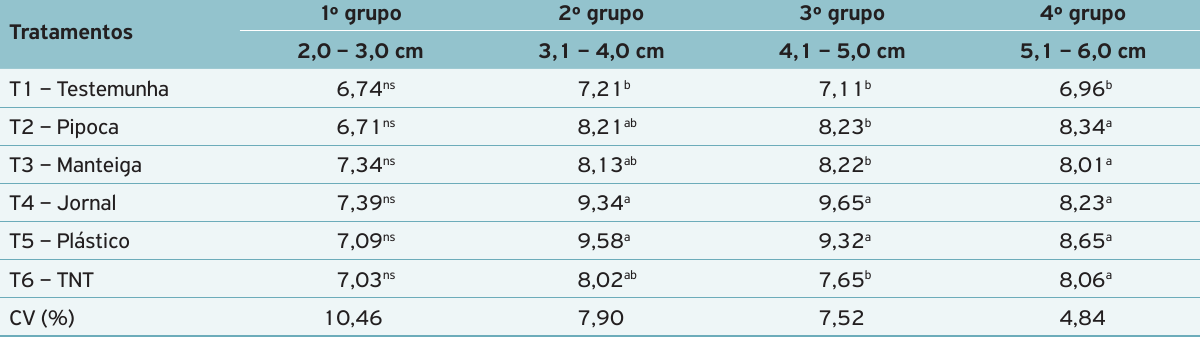
Tabela 3. Valores médios de comprimento obtidos em quatro grupos de diâmetros de goiabas ensacadas com diferentes sacos em um pomar comercial no Crato, Ceará, entre 13 de outubro de 2011 e 16 de abril de 2012.